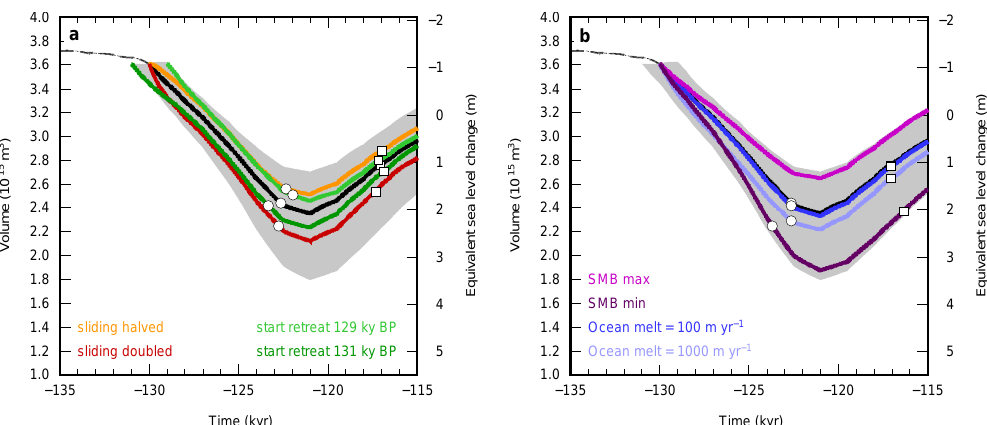
Fig. 7. Simulated GrIS volume change and equivalent sea level contribution through the Eemian in different sensitivity experiments: (a) ex- periments using a different start of the Eemian warming and a perturbed sliding velocity, (b) experiments with additional mass loss due to ice–ocean contact and perturbations in the SMB forcing. Circles (squares) indicate the timing ice margin retreat (re-advance) at Dye-3. Com- plete retreat from the Dye-3 location did not occur in the SMB min experiment, when the ice margin remained exactly on that location during the minimum extent. Background shading represents the uncertainty estimate based on the RMS differences of the sensitivity experiments.